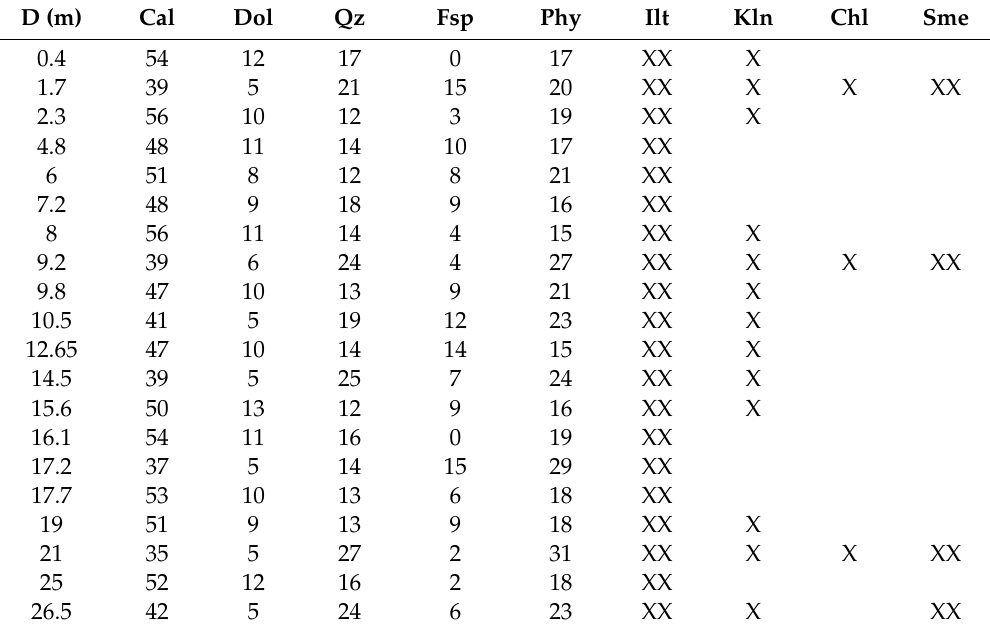
Table 7. XRD analysis of the samples from Tablate B locality in the southeastern edge of the Granada Basin. The distance corresponds to the distance from fault, which is also plotted on the x-axes of the plots in Figure